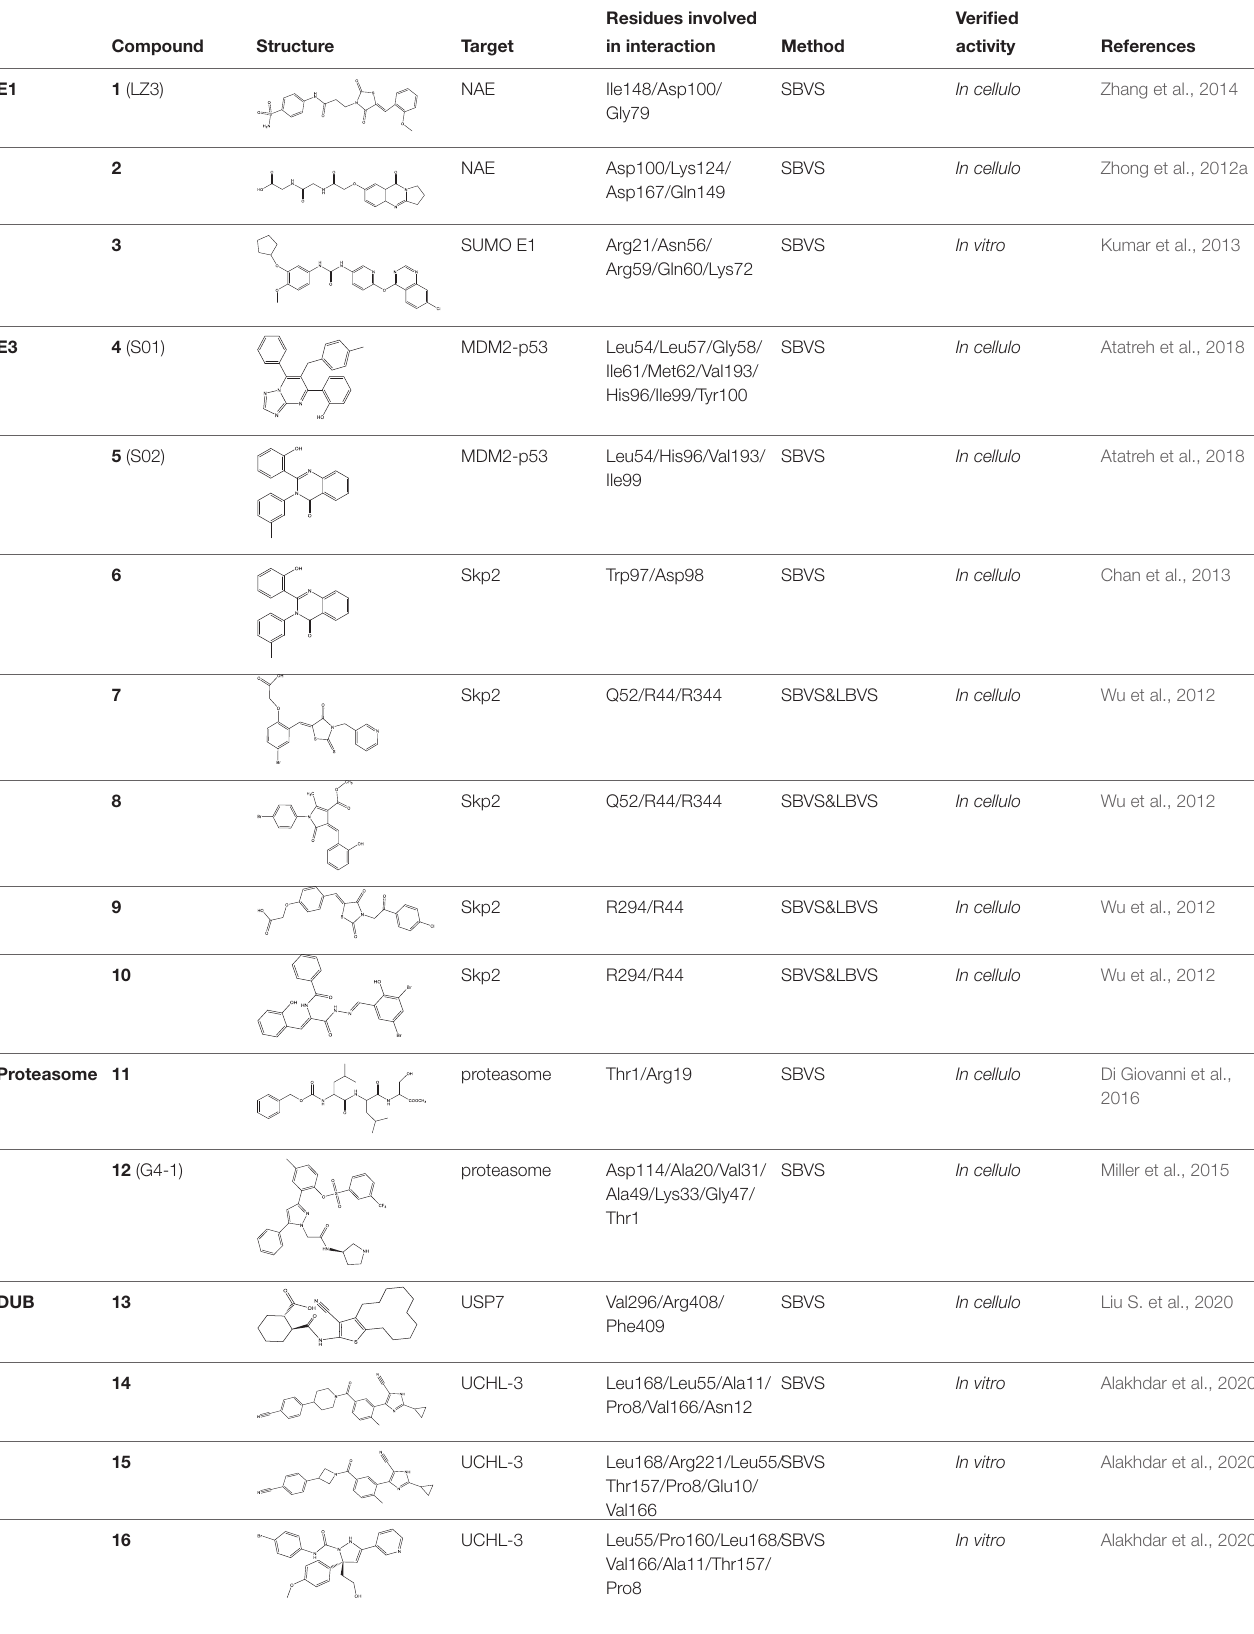
TABLE 1 | Ubiquitination regulators identified by virtual screening.